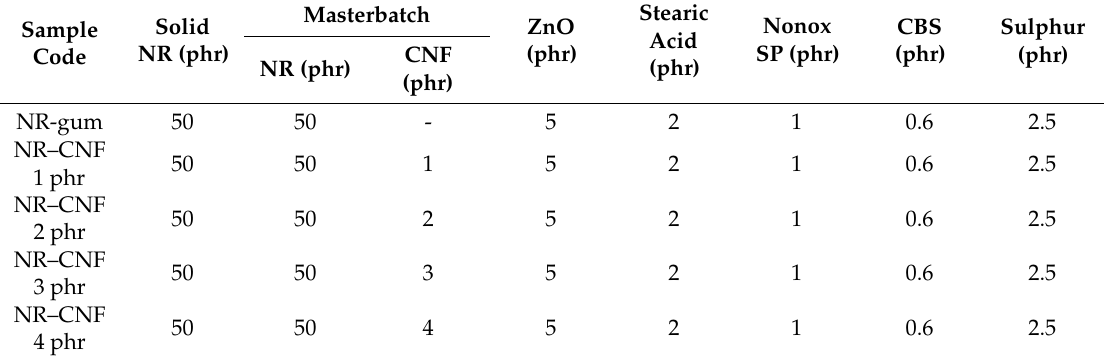
Table 1. Formulation and coding of natural rubber (NR)–cellulose nanofiber (CNF)